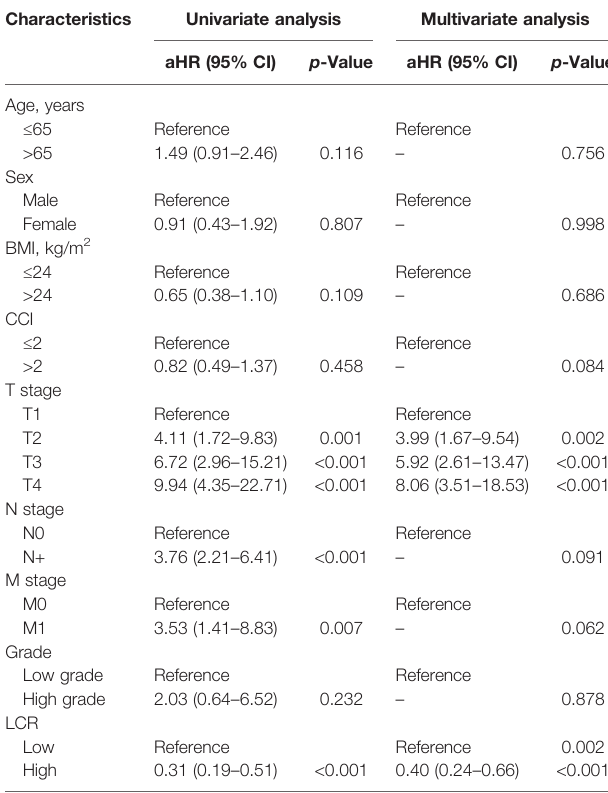
TABLE 3 | Relative risk of disease-free survival